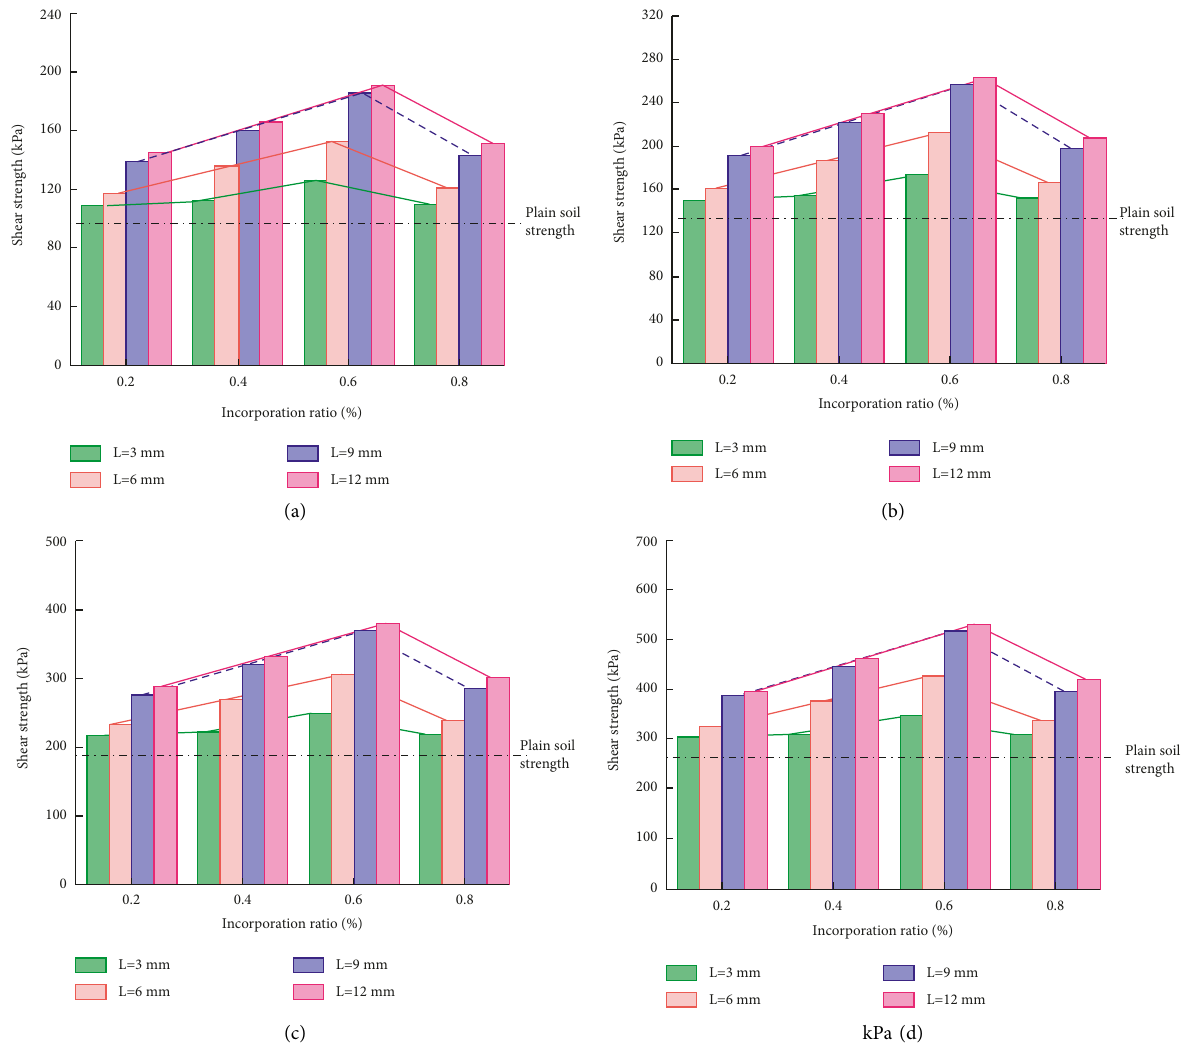
Figure 8: Relationship of damage strength under different circumferential pressures (a) 50 kPa (b) 100kPa (c) 150kPa (d)